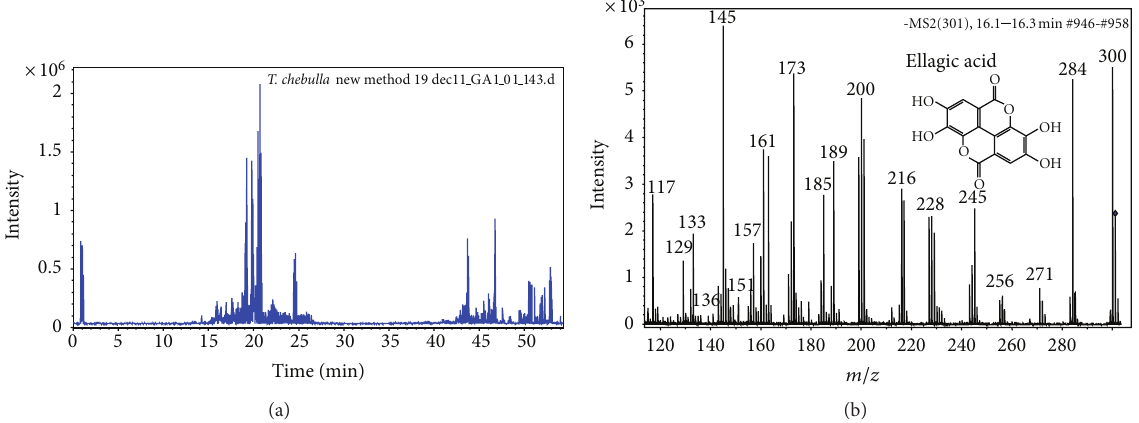
Figure 2: Chromatograms obtained from reversed-phase LC-ESI-QTOF-MS analysis of Terminalia belerica extract. (a) Total ion chromatogram (QTOF MS); (b) corresponding to m/z for the most intense peaks view of MS/MS spectrum pattern of Ellagic acid.